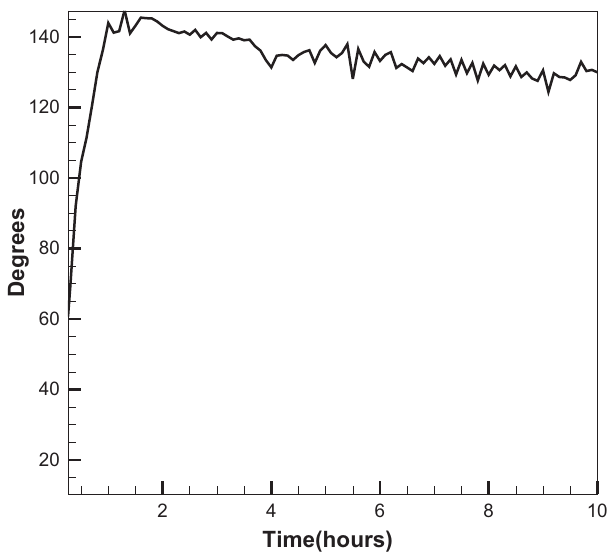
Fig. 5. The evolution of the spread angle of the CME in